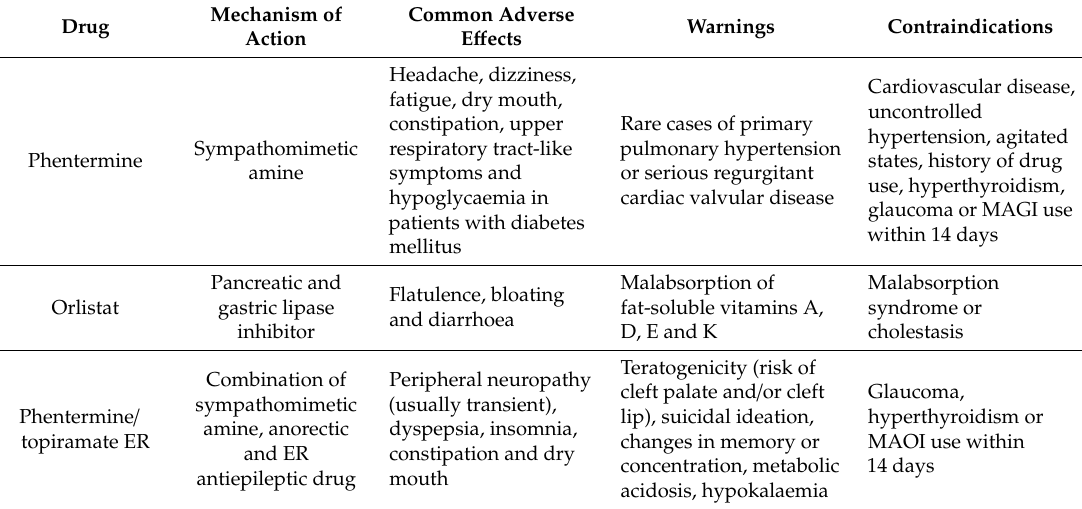
Table 6. Pharmacotherapy of obesity